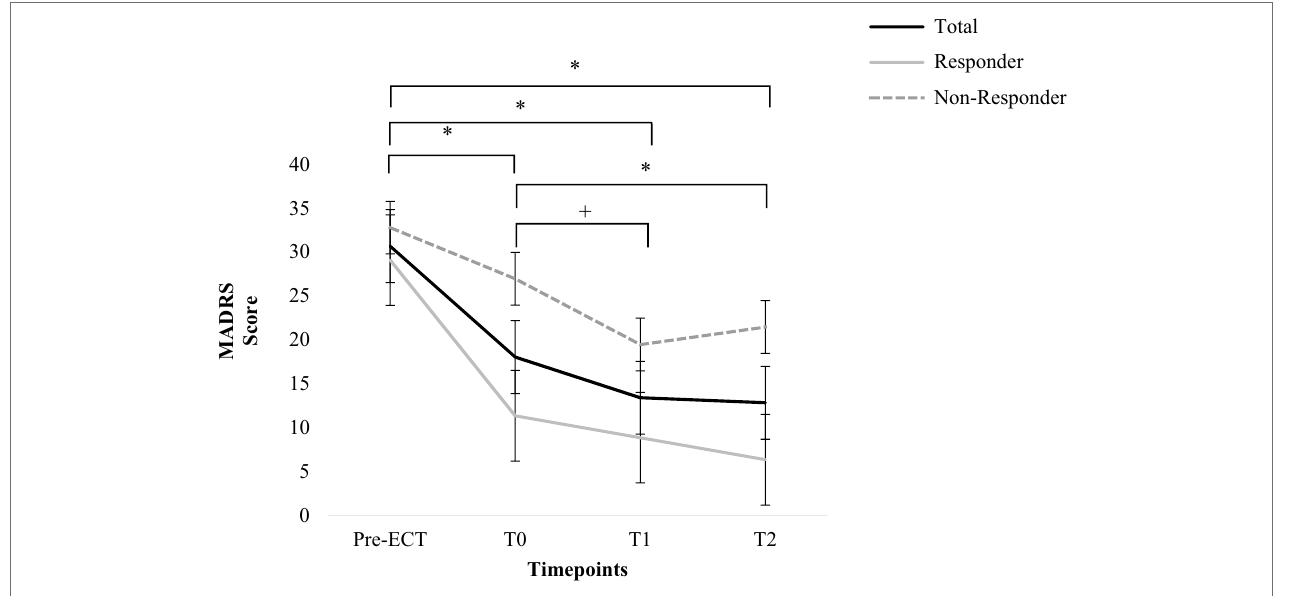
FIGURE 2 | Change in Montgomery-Åsberg Depression Rating Scale score for total sample, responders, and non-responders. Error bars represent standard errors. * = p < 0.05; + = p = 0.05 (total sample).